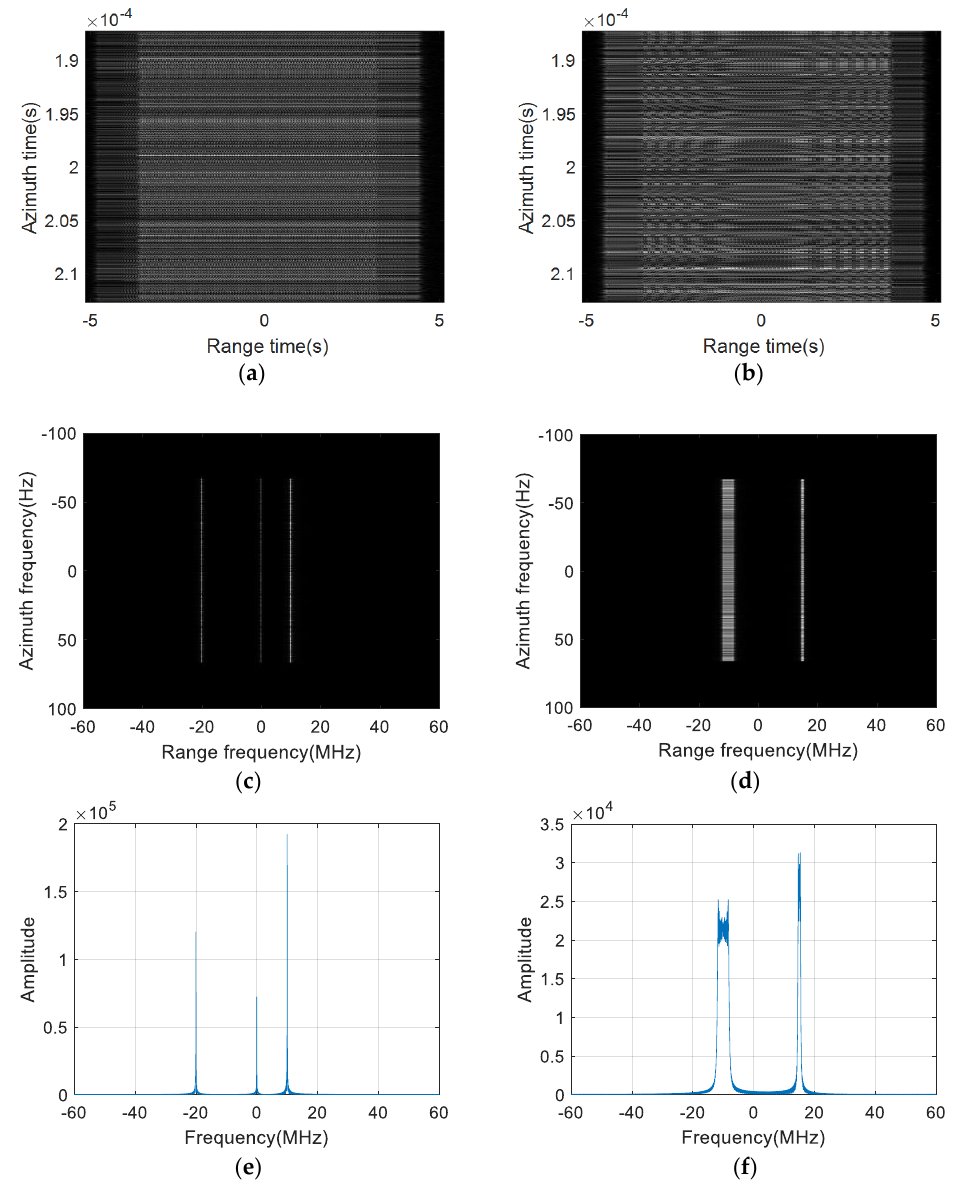
Figure 1. NBI and WBI in different domains. ( a ) NBI in the 2D time domain; ( b ) WBI in the 2D time domain; ( c ) NBI in the 2D frequency domain; ( d ) WBI in the 2D frequency domain; ( e ) NBI in the range frequency domain; ( f ) WBI in the range frequency domain. Table 2. Simulation parameters of the experiments.